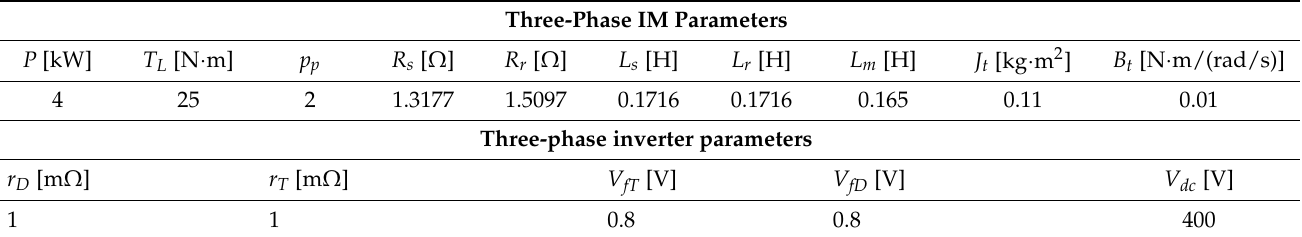
Table 1. Main parameters of the sensorless IM drive system.